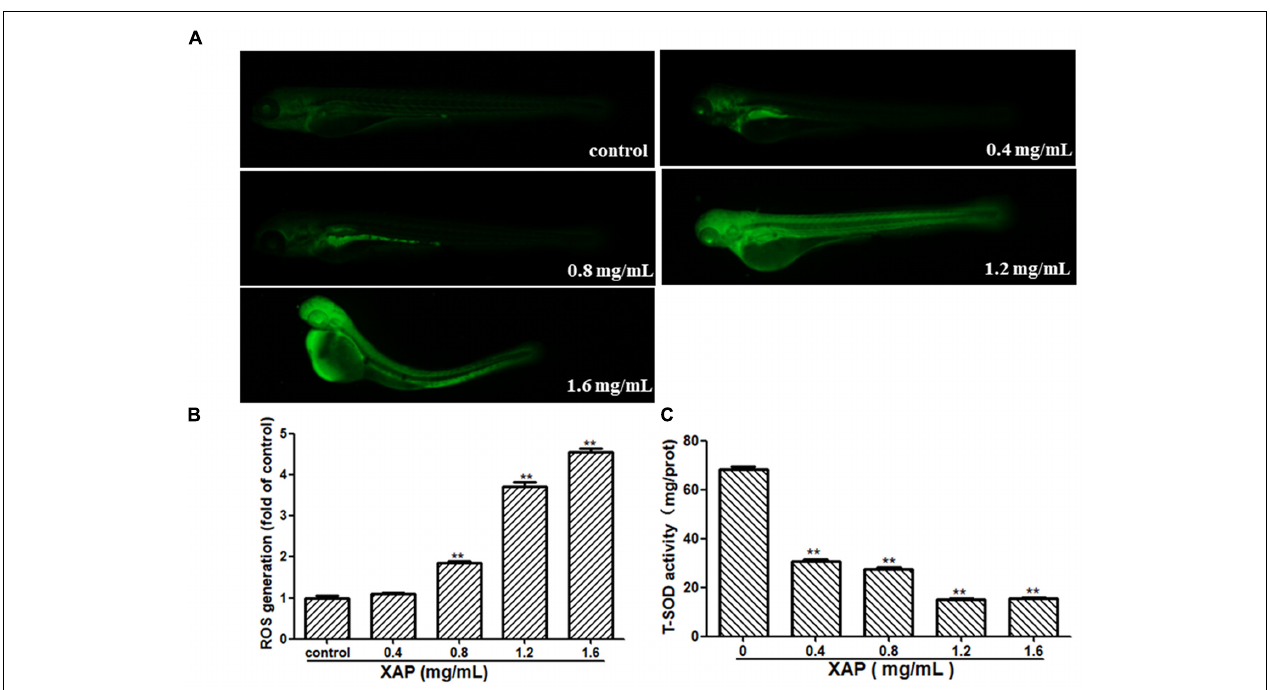
FIGURE 6 | Changes in ROS levels induced by XAP at 120 hpe. (A) ROS generation was identified as green fluorescence on a black background after XAP exposure. (B) The quantitative analysis of ROS generation after XAP exposure. (C) The change of T-SOD activity after XAP exposure. ∗ P < 0.05, ∗∗ P < 0.01 versus control.